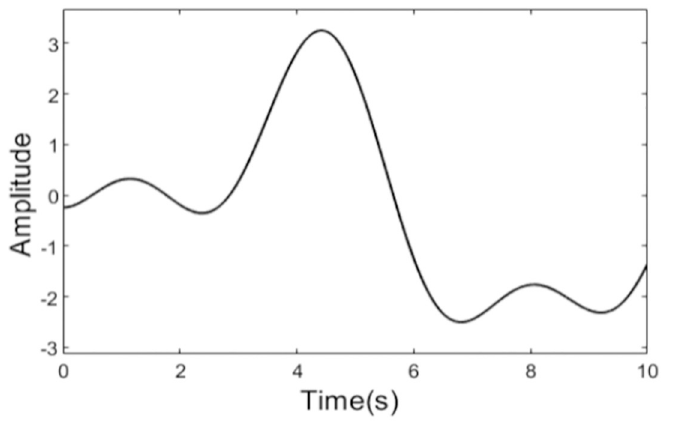
Fig 4. The designed path.